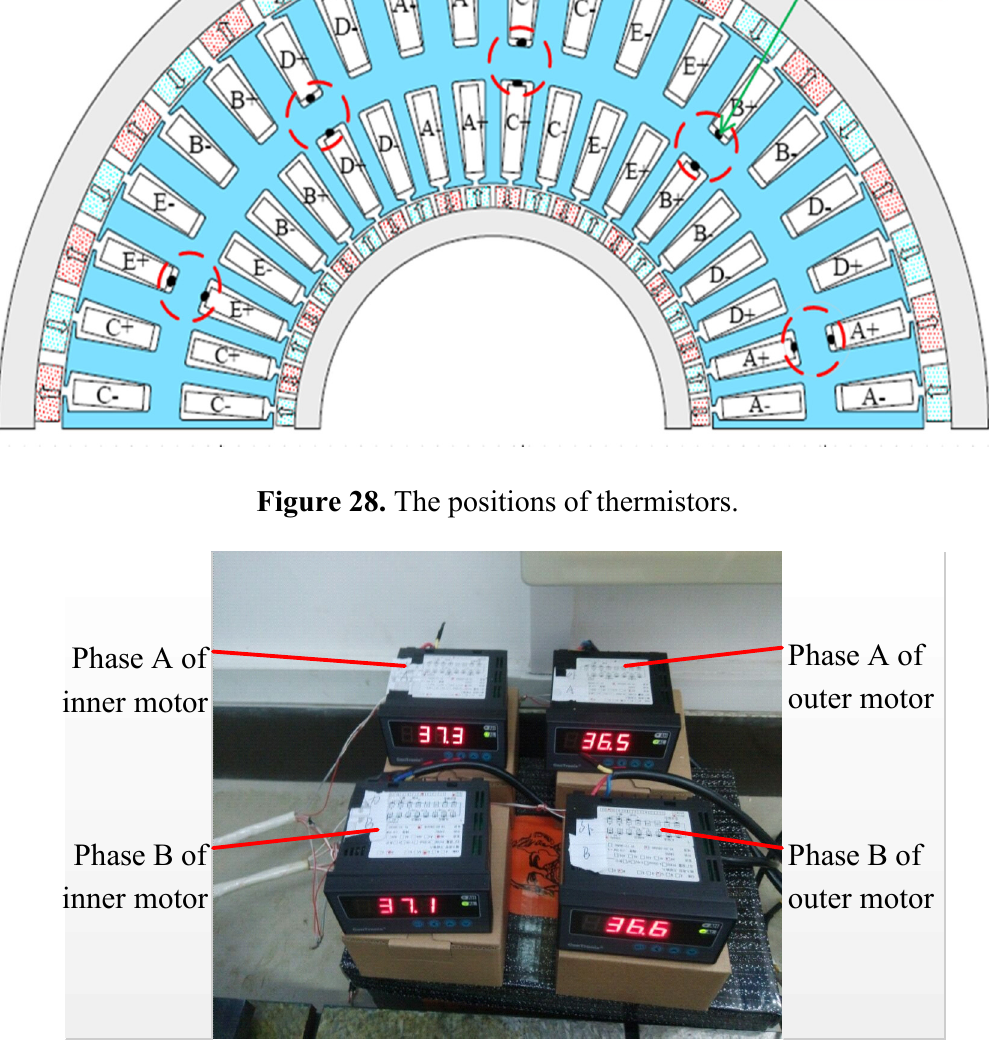
Figure 29. The temperature measuring